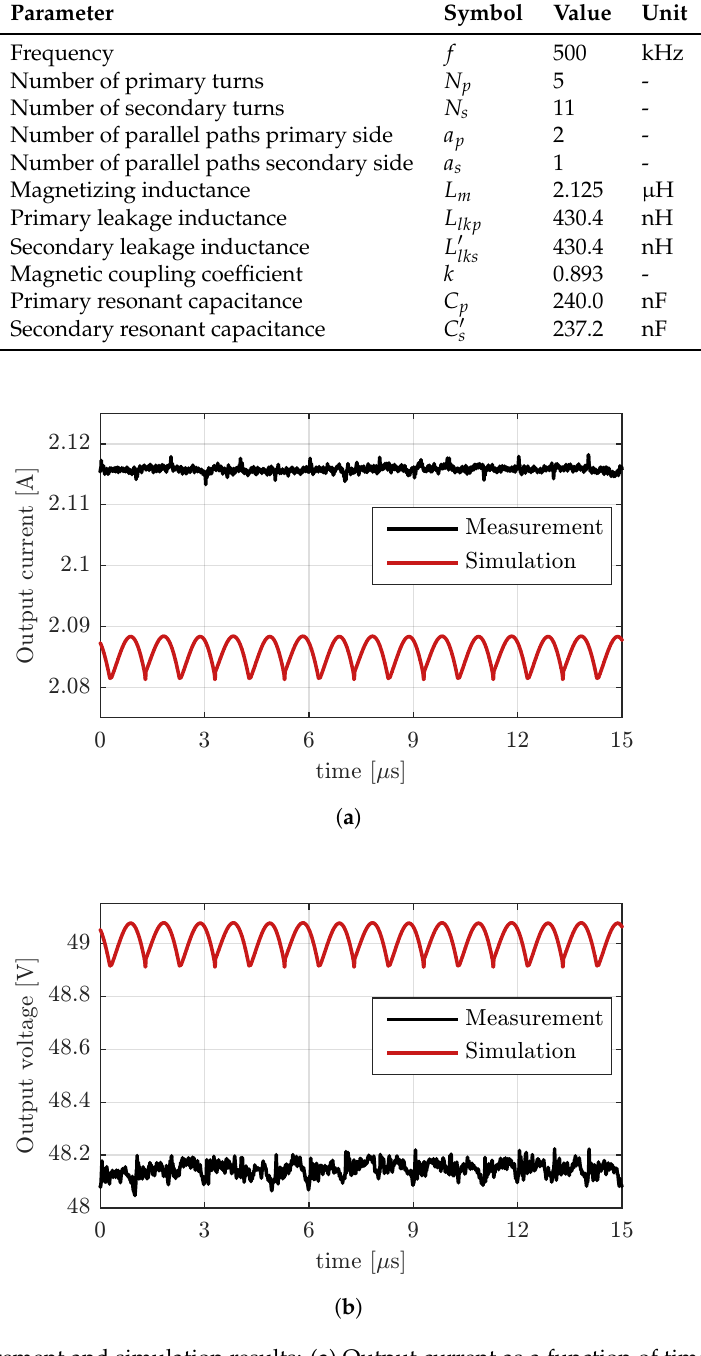
Figure 7. Measurement and simulation results: ( a ) Output current as a function of time, and ( b ) output voltage as a function of